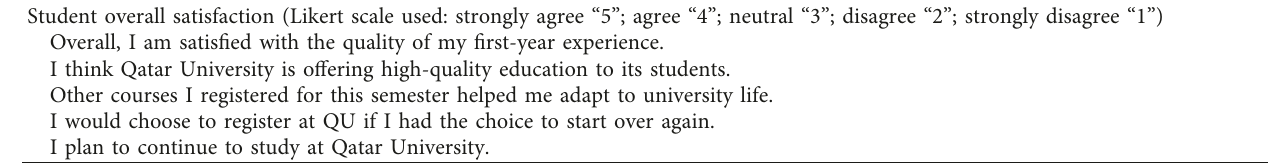
Table 1: Items used for each